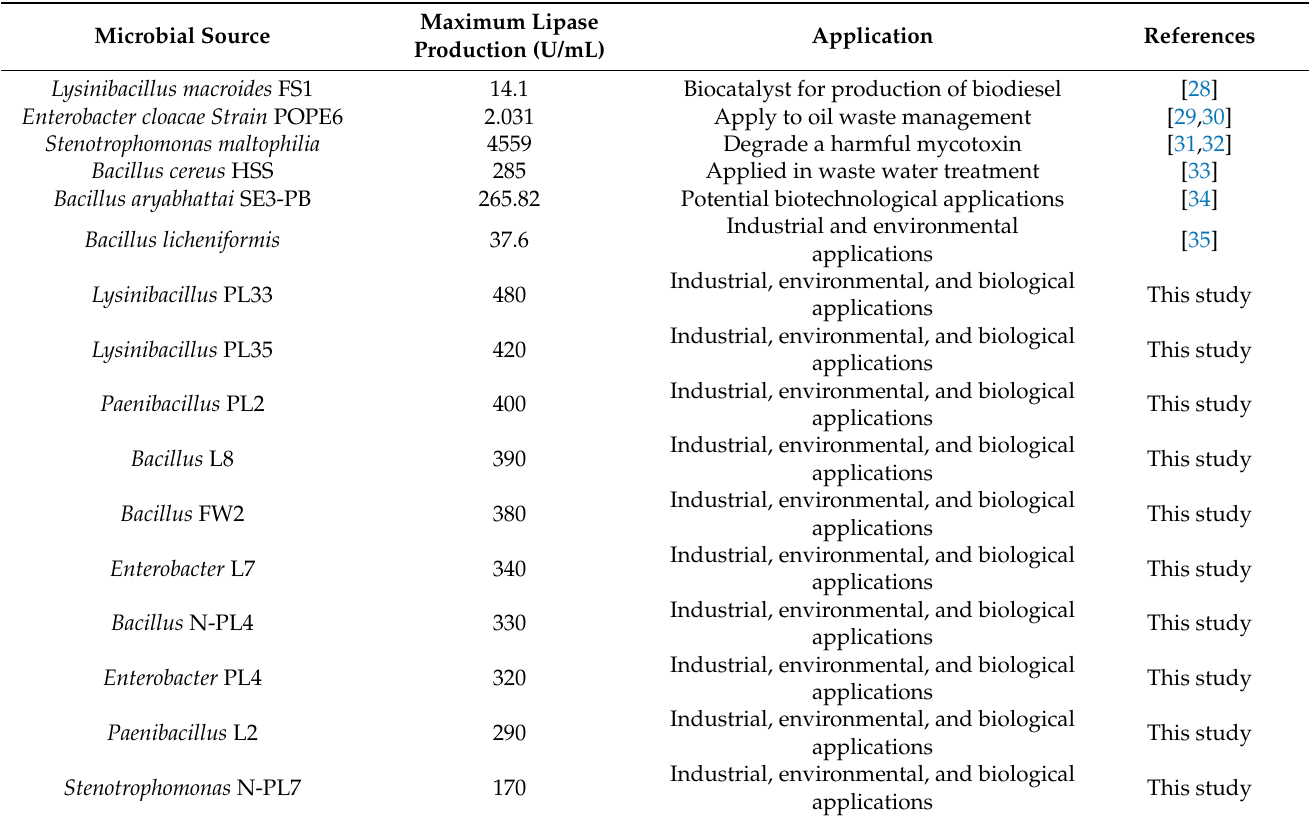
Table 3. The list of lipase-producing bacteria which belong to the same genus from the previous studies compared to ten bacterial strains in this